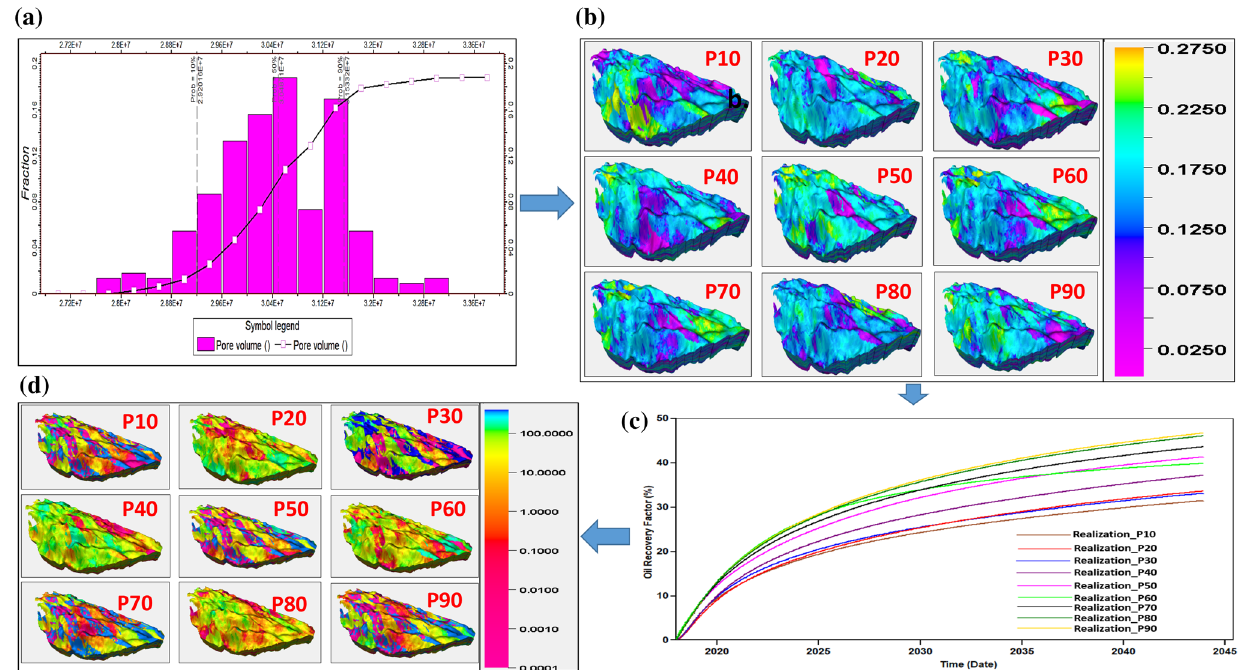
Fig. 14 a Histogram of the 200 porosity realization. b 3D models’ distribution of the porosity realizations. c The nine ranked permeability mod- els selected for optimization studies. d Oil recovery factor for the different geological